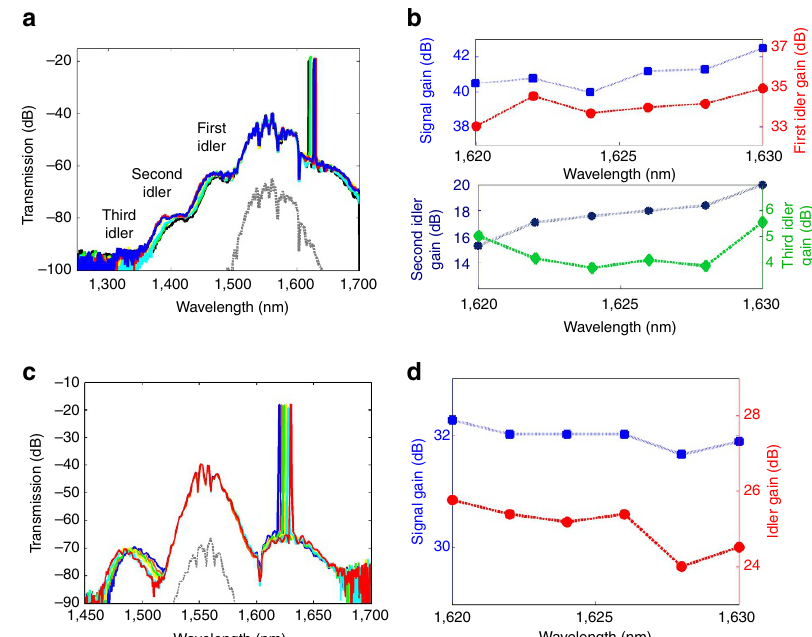
Figure 5 | Optical parametric-amplification and cascaded four-wave mixing using a 500fs pump. ( a ) Transmission spectrum as a function of wavelength for a peak pump power of 14W. Cascaded four-wave mixing down to the third idler at 1,300nm is observed. Solid lines denote the measured spectra with the signal located at 1,620 (black), 1,622 (green), 1,624 (cyan), 1,626 (yellow), 1,628 (blue) and 1,630nm (red). The grey dashed curve represents the pump spectrum offset by (cid:3) 25dB, with the signal off. ( b ) Measured parametric gain in the signal (blue squares), first (red circles), second (dark blue stars) and third idlers (green diamonds). ( c ) Transmission spectrum as a function of wavelength for a peak pump power of 10W. Solid lines denote the measured spectra with the signal located at 1620 (blue), 1,622 (orange), 1,624 (green), 1,626 (yellow), 1,628 (cyan) and 1,630nm (red). The grey dashed curve represents the pump spectrum offset by (cid:3) 25dB, with the signal off. ( d ) Measured signal (blue squares) and idler gain (red circles) as a function of signal wavelength. Dotted lines in b , d are a guide to the